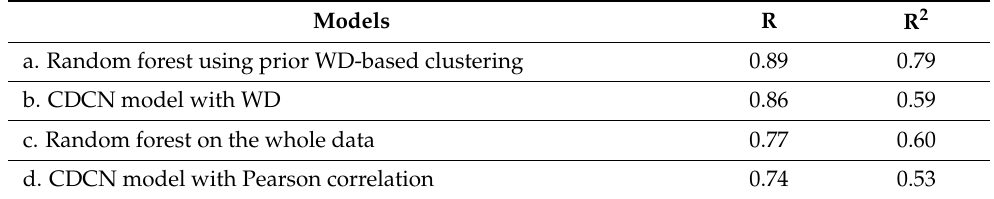
Table 1. Performance comparison of four different models. CDCN: Cell-line drug complex network; WD: Wasserstein